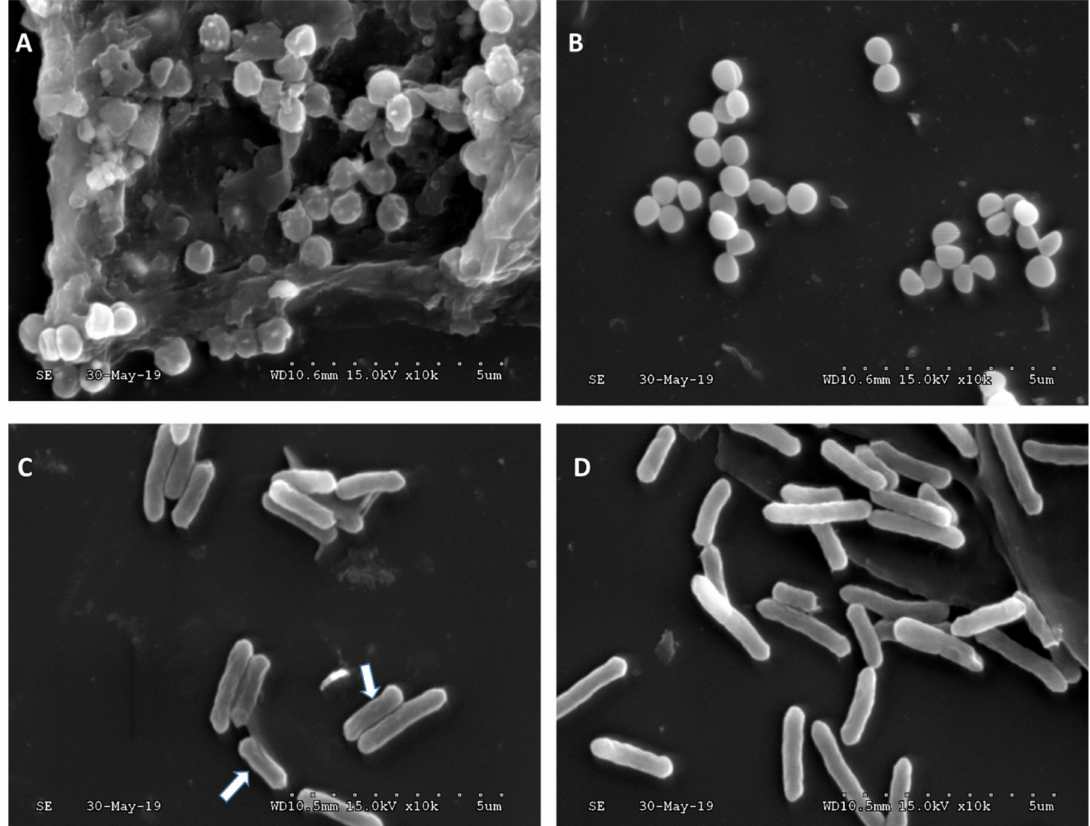
Figure 4. SEM images of S. aureus incubated ( A ) in the presence of P(CL- ran -ATC 50.9%) (3000 µ g mL − 1 ), ( B ) in the absence of polymer; E. coli incubated ( C ) in the presence of P(CL-ran-ATC 50.9%) (3000 µ g mL − 1 ), ( D ) in the absence of polymer. The scale bar was 5 µ m. Surprisingly, homopolymer PATC presented a weaker antibacterial e ff ect than P(CL- ran -ATC 22.8%) and P(CL- ran -ATC 50.9%). It reminded the lipophilic segment is necessary for